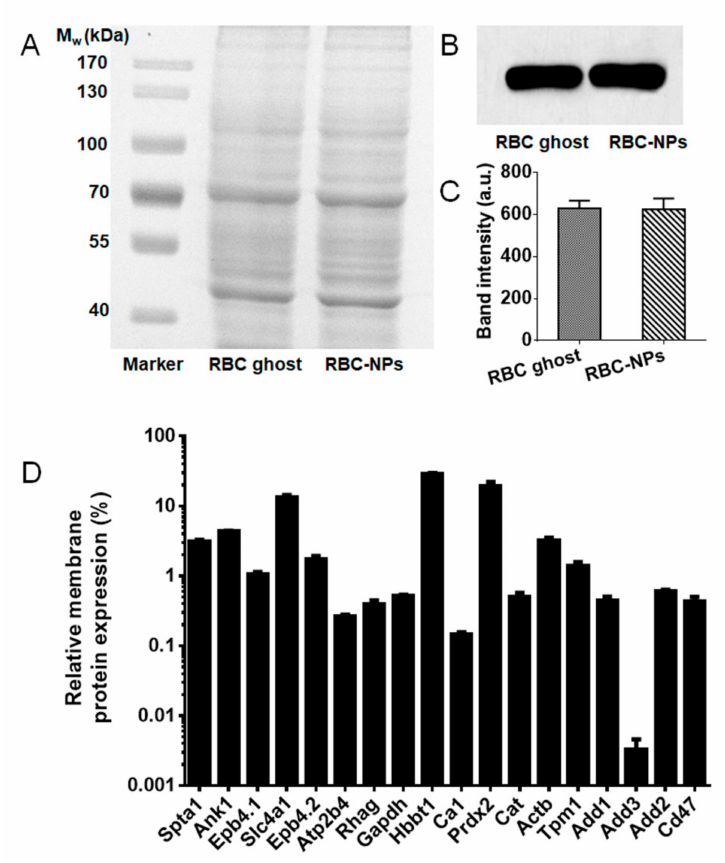
Figure 2. Protein characterization. ( A ) SDS-PAGE protein analysis of RBC ghost and RBC-NPs at equivalent protein concentrations. ( B ) Western blotting analysis of membrane-specific protein marker CD47 in RBC ghost and RBC-NPs. ( C ) Quantification of western blot band intensity of CD47 in RBC ghost and RBC-NPs ( n = 3). ( D ) The relative expression of typical RBC membrane proteins based on the label-free quantification